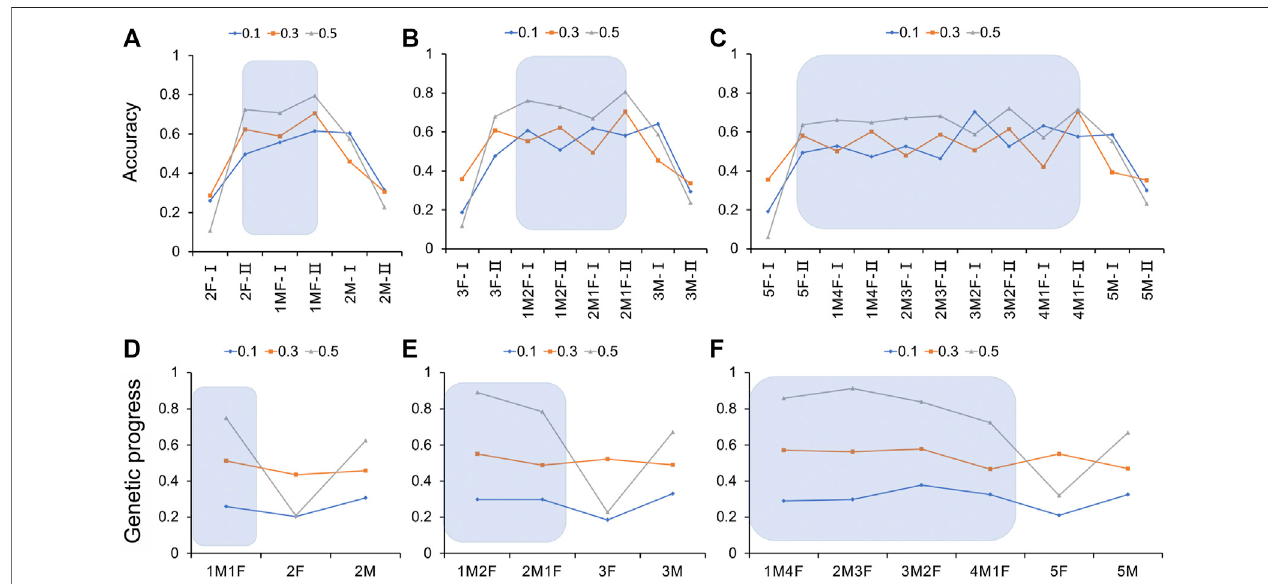
FIGURE 5 | Estimation accuracy and genetic progress when the genotyping ratio was 20, 30, and 50% of the candidate population for different heritability traits. (A – C) Estimation accuracy when the genotyping ratio was 20, 30, and 50% of the candidate population for different heritability traits; (D – F) Genetic progress when the genotyping ratio was 20, 30, and 50% of the candidate population for different heritability traits. M, male; F, female; I, boar; II, gilt.